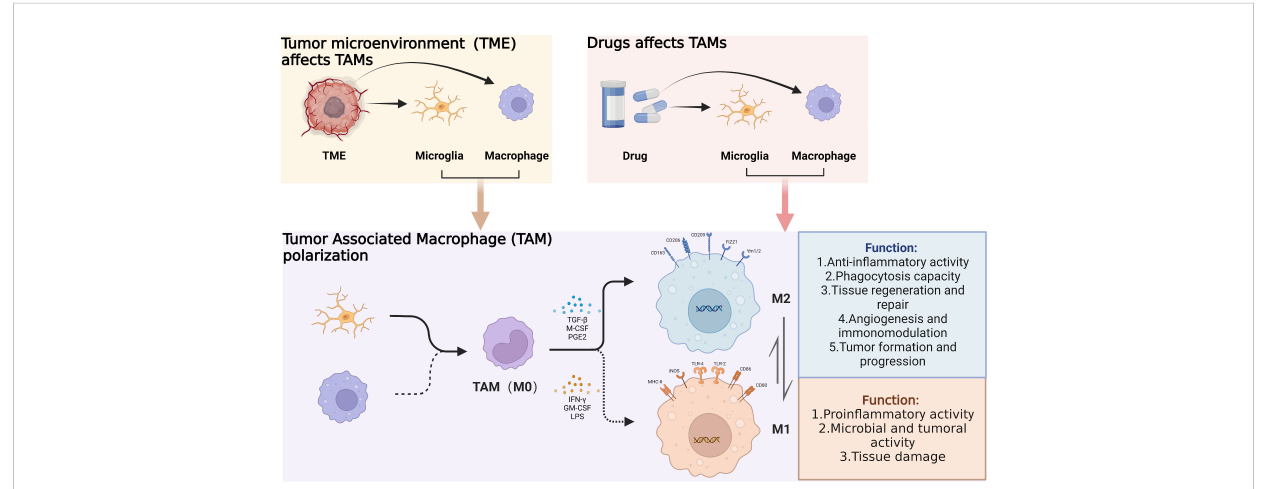
FIGURE 2 Under the in fl uence of the glioma microenvironment and corresponding drugs, tumor-associated macrophages are recruited toward the tumor. And under the action of certain cytokines, the polarization direction of tumor-associated macrophages changes, resulting in different physiological functions. (By